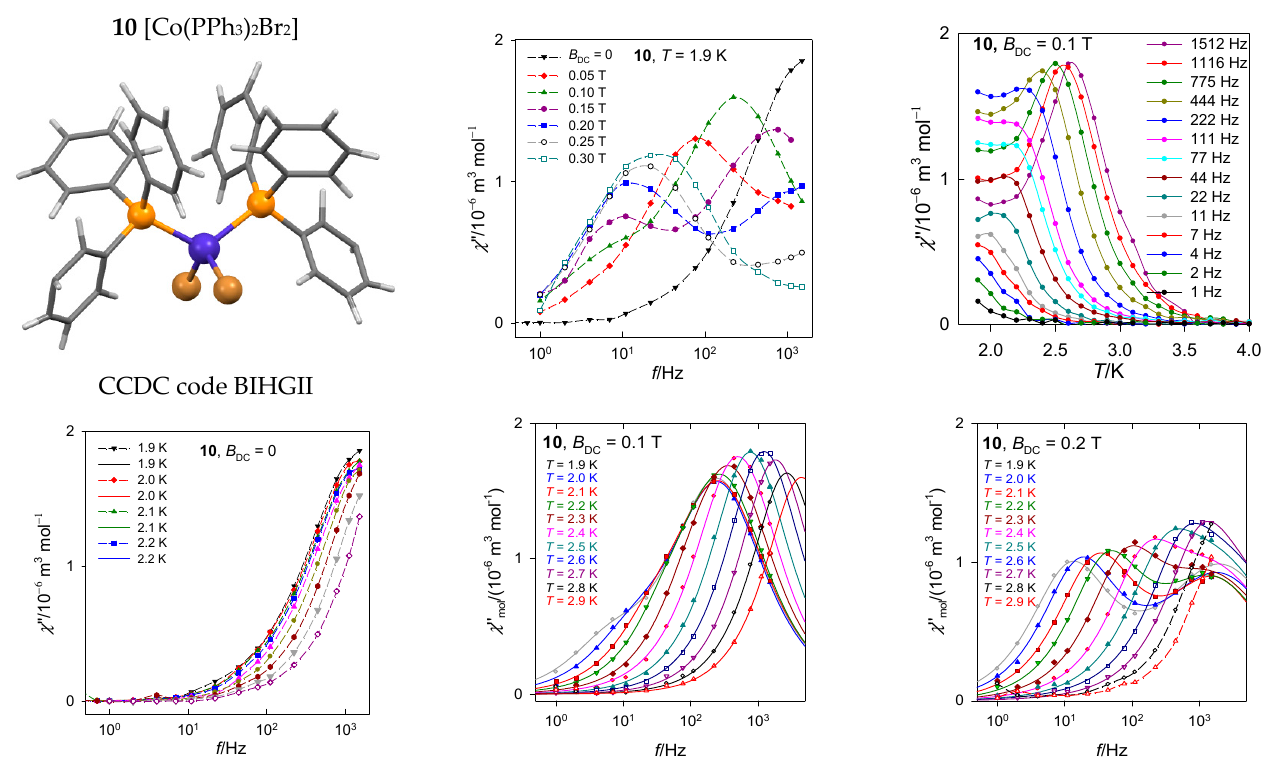
Figure 18. Frequency dependence of the out-of-phase susceptibility at various temperatures and external fields for [Co(PPh 3 ) 2 Br 2 ], 10 . Solid lines—fitted; dashed—guide for eyes. Data adapted from ref. [47]. 2014, American Chemical Society.